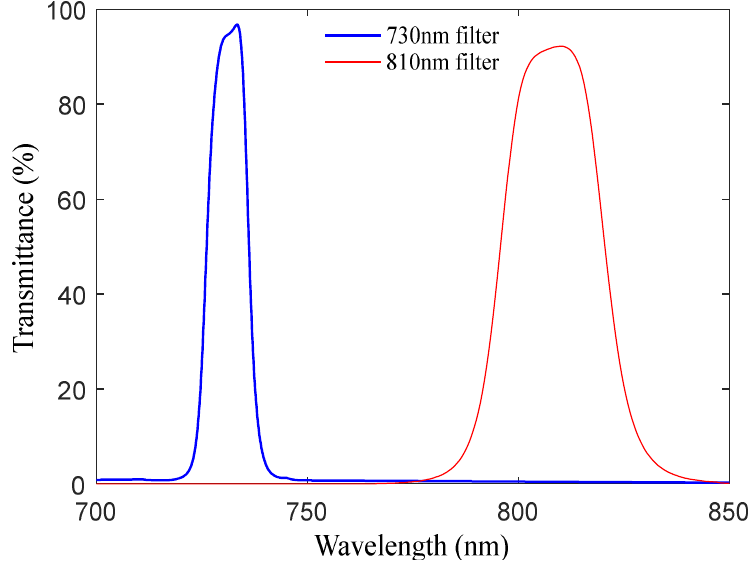
Figure 8. The light transmittance of two different optical filters.